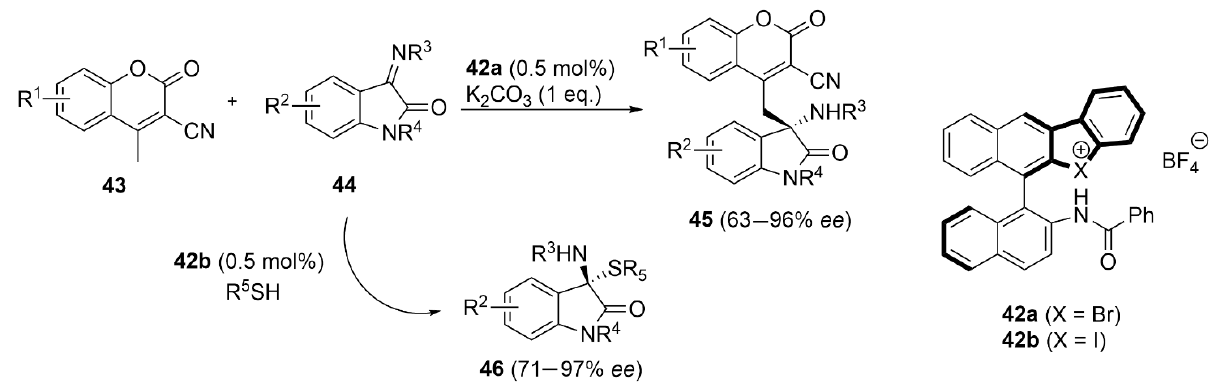
Figure 21. XB/HB-catalyzed asymmetric additions to ketimines 44 .